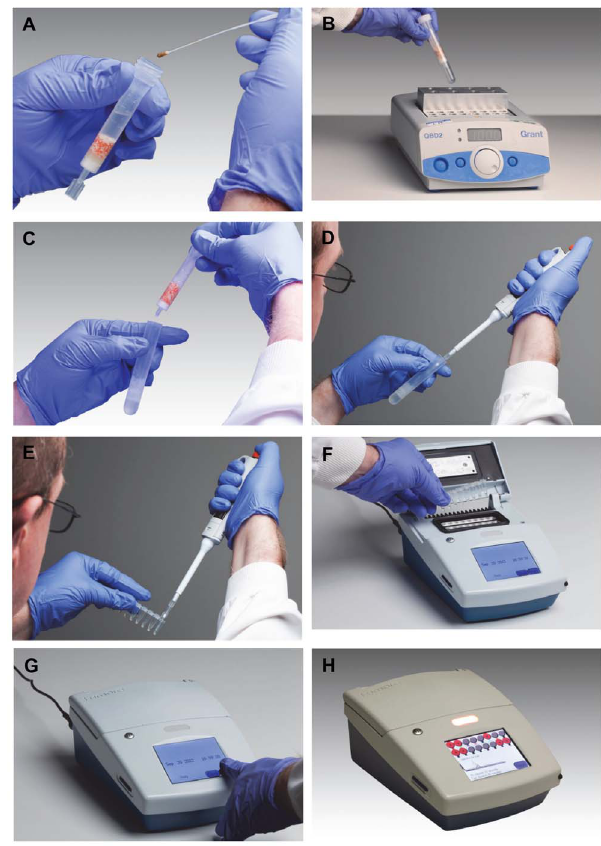
Figure 1. Photographic illustration of the steps of the HE- LAMP-BART. A. Place fecal swab sample into the HE column, mix,